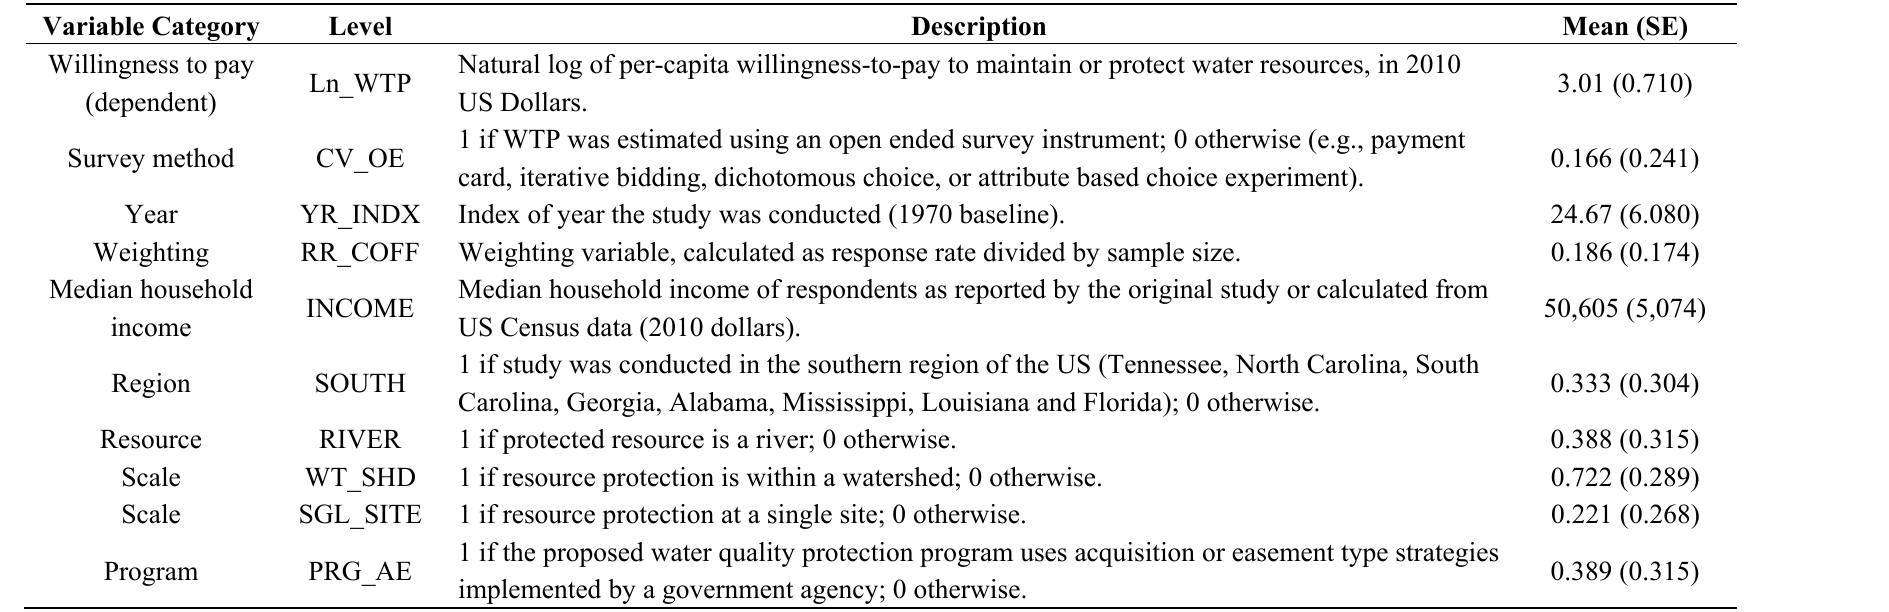
Table 2. Meta-analysis model variables and